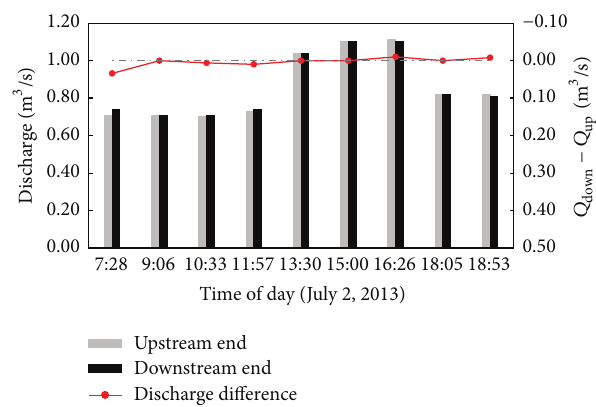
Figure 6: Diurnal variations of the discharge at the upstream and downstream ends (July 2,